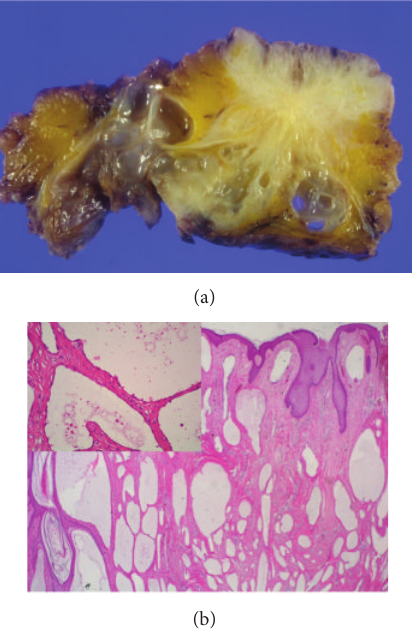
Figure 3: Multiple, thin walled irregular shaped cysts growing in the umbilicus (a), thin-walled cysts lined by flattened or cuboidal mesothelial cells (b).